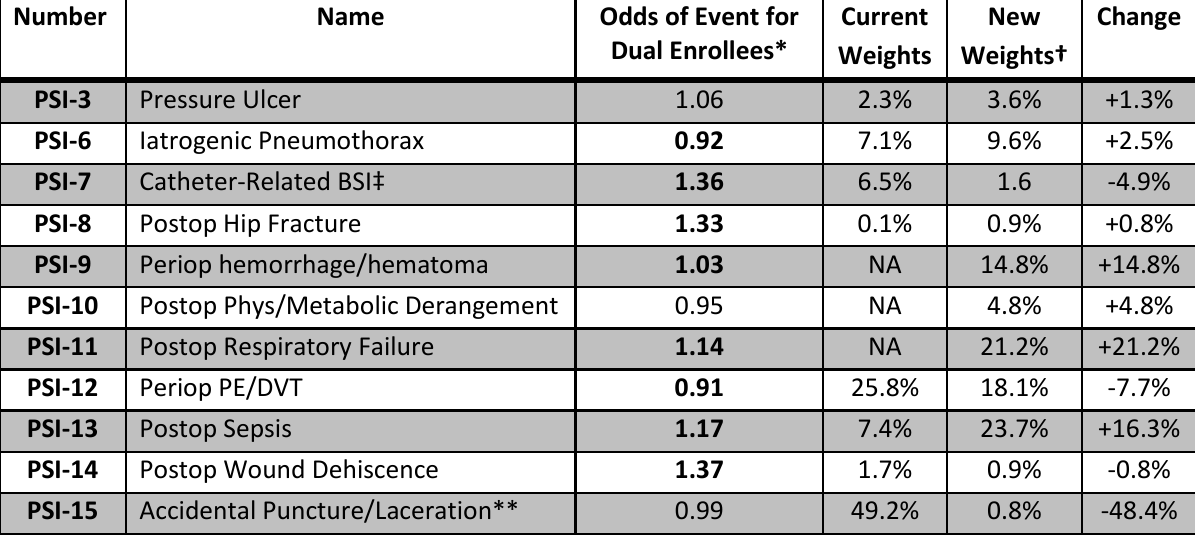
Table 6.22. PSI-90 version 6, Harms-based and volume-based weights